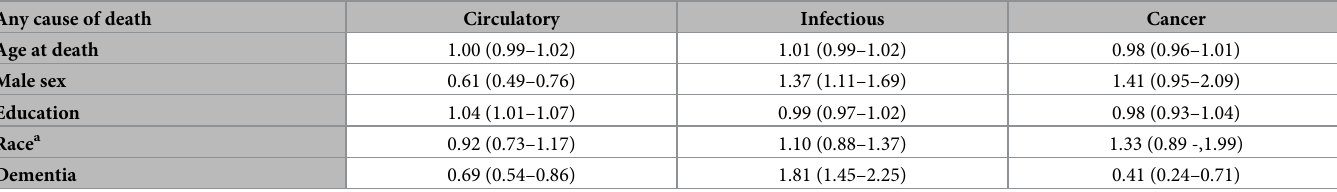
Table 3. Logistic regression models for the association of dementia and all causes of death adjusted for age at death, sex, education and race, OR (95%CI). Any cause of